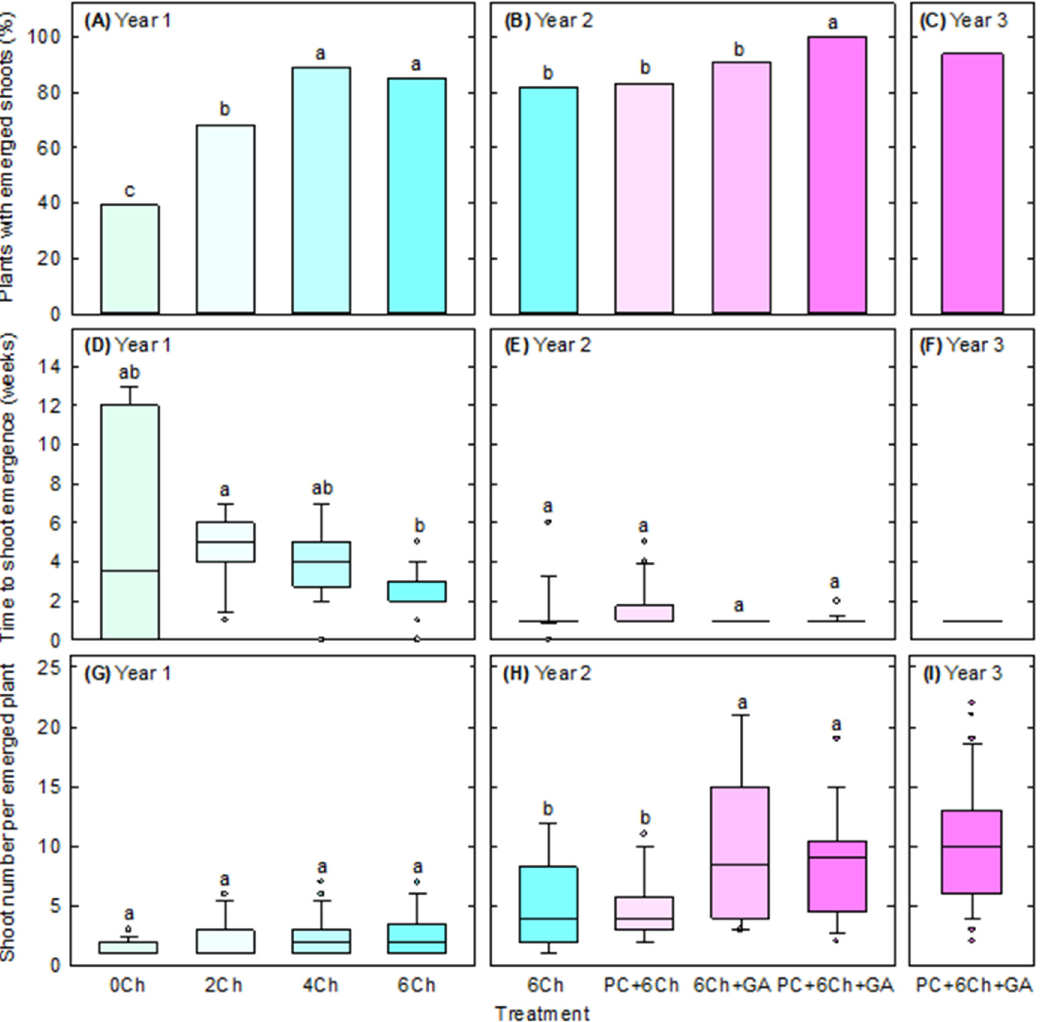
Figure 3. Percentage of peony plants with emerged shoots in ( A ) Year 1, ( B ) Year 2 and ( C ) Year 3; the time after chilling to first shoot emergence in ( D ) Year 1, ( E ) Year 2 and ( F ) Year 3; and the number of shoots per emerged plant in ( G ) Year 1, ( H ) Year 2 and ( I ) Year 3. ‘0Ch’, ‘2Ch’, ‘4Ch’ and ‘6Ch’ = 0, 2, 4 or 6 weeks of chilling at 4 °C, respectively; ‘PC’ = pre-treatment from 20 °C to 8 °C prior to chilling; ‘GA’ = GA 3 treatment after chilling. Means are presented in ( A – C ); medians ( D – I ) are presented with 25th and 75th percentiles (boxes), 10th and 90th percentiles (whiskers), and outliers (circles). Means or medians in the same year with different letters are significantly different (Binomial tests with Holm–Šidák corrections, or Kruskal–Wallis and Dunn’s tests with Bonferroni corrections; p < 0.05, n = 18–65).